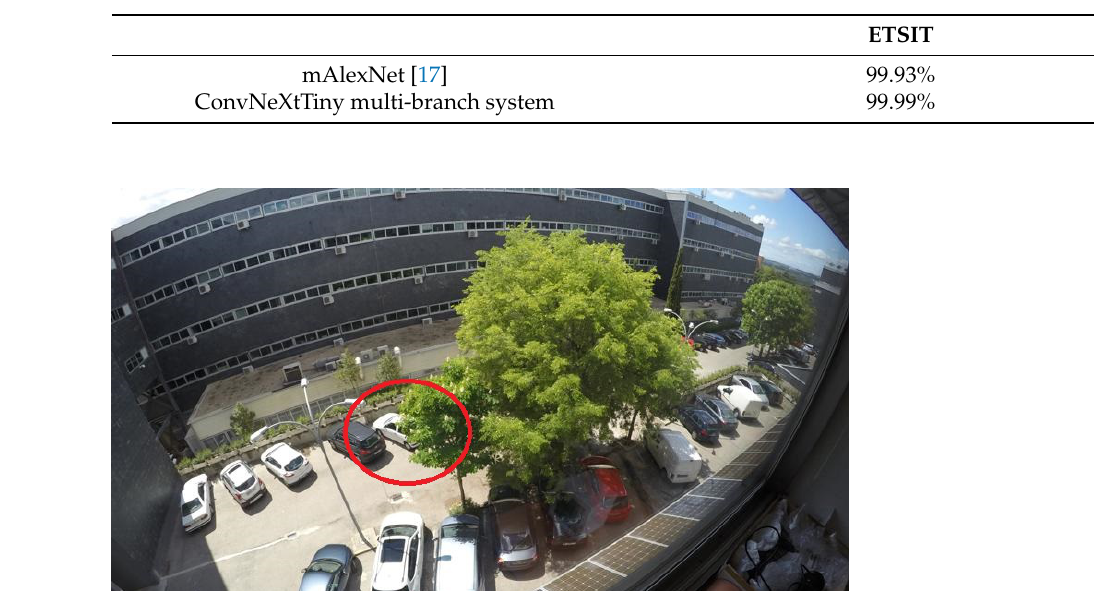
Table 9. Comparison between the ConvNeXtTiny multi-branch system and the mAlexNet system [17] for the ETSIT dataset.